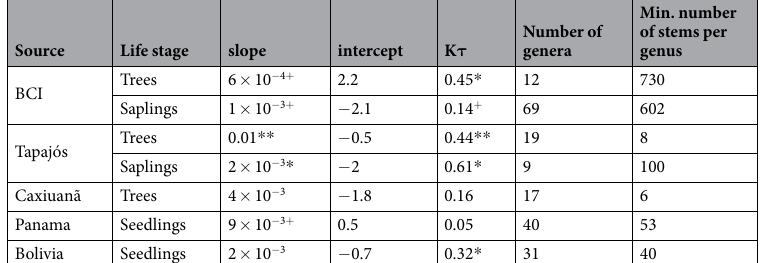
Table 2. Relationship between drought mortality ( ∆ m) and water deficit affiliation (WDA) in five droughted locations in the Neotropics. Slope and intercept from standardized major axis regressions (SMA) and Kendall’s τ coefficient of correlation (K τ ) between ∆ m and WDA were calculated for the 1982–3 El Niño drought in BCI 17 , two throughfall exclusion experiments in the Brazilian Amazon, Tapajós 40 and Caxiuanã 16 , and two seedling experiments, one in Panama 4 the other in Bolivia 12 . For BCI, Tapajós and Caxiuanã the relationship ∆ m vs . WDA was calculated for the subset (number of genera), including only genera with the minimum number of stems needed to permit estimation of mortality for that experiment (see Supplementary methods S2). The minimum number of stems per genus varied depending on the duration of the drought (Supplementary methods S2). One-tail P-values test (1) whether the slope differs from zero and (2) the null hypothesis of a positive relationship (positive values of K τ ) between ∆ m vs . WDA. The latter analysis was repeated using two-tailed tests, which showed no difference on the results (Supplementary Table S6). + P < 0.1, * P < 0.05; ** P < 0.01.